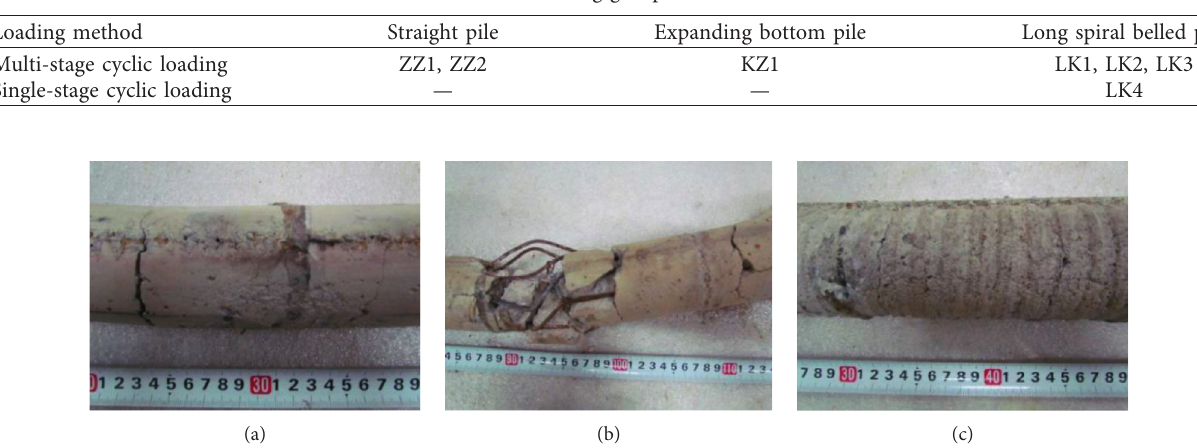
Table 3: Pile loading group for indoor test.